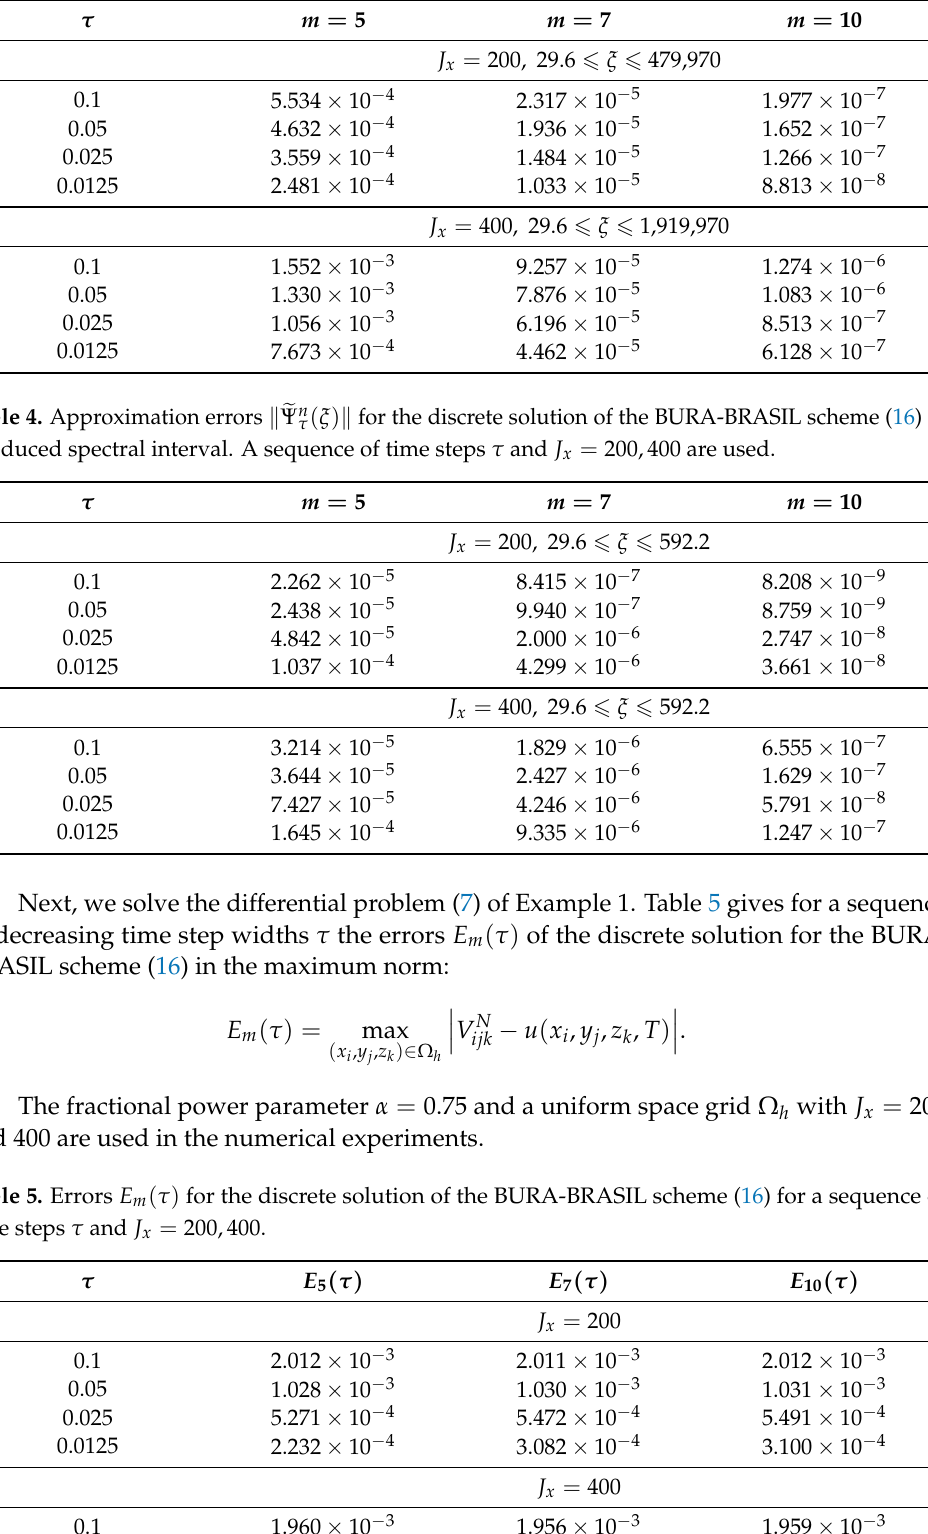
Table 3. Approximation errors (cid:107) (cid:101) Ψ n τ ( ξ ) (cid:107) for the discrete solution of the BURA-BRASIL scheme (16) for a sequence of time steps τ and J x = 200,400.